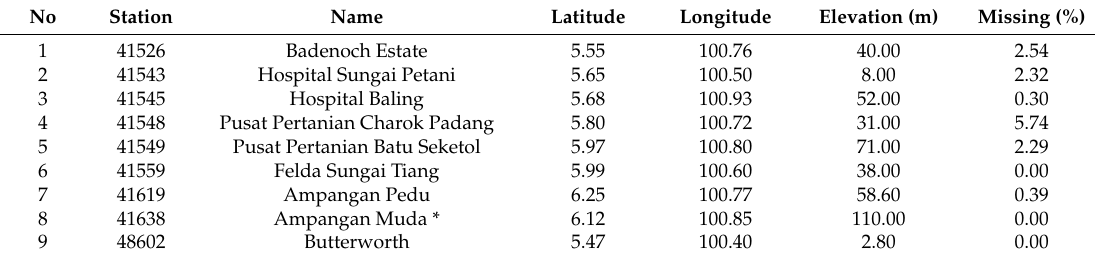
Table 1. Stations information and rainfall missing